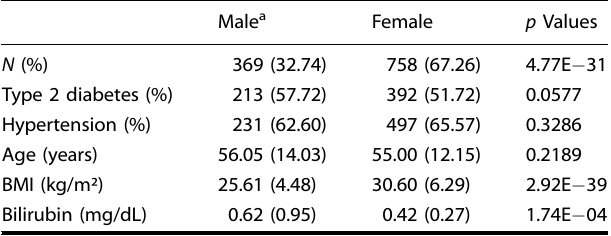
Table 1. Study characteristics for genome-wide association study.